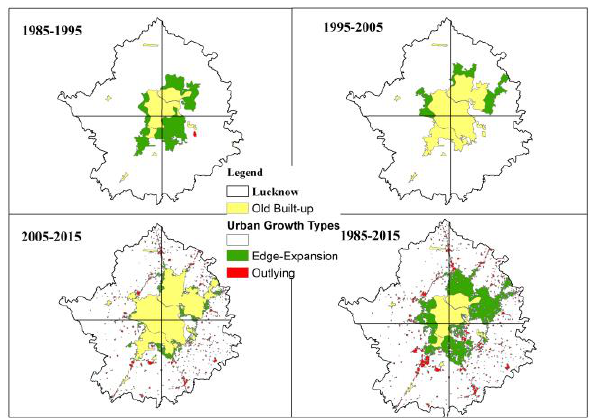
Figure 5. Types of Urban growth in different years.